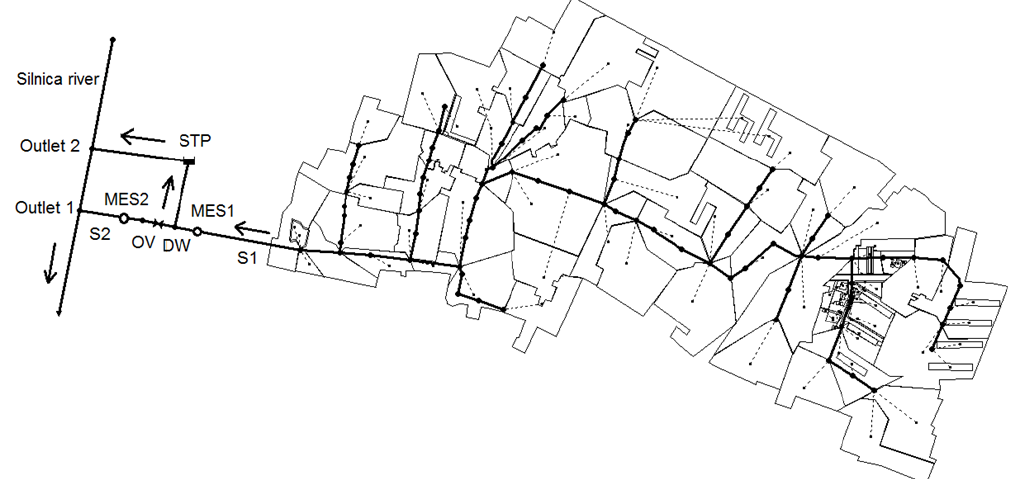
Figure 1. Scheme of the hydrodynamic model of the catchment generated in the SWMM